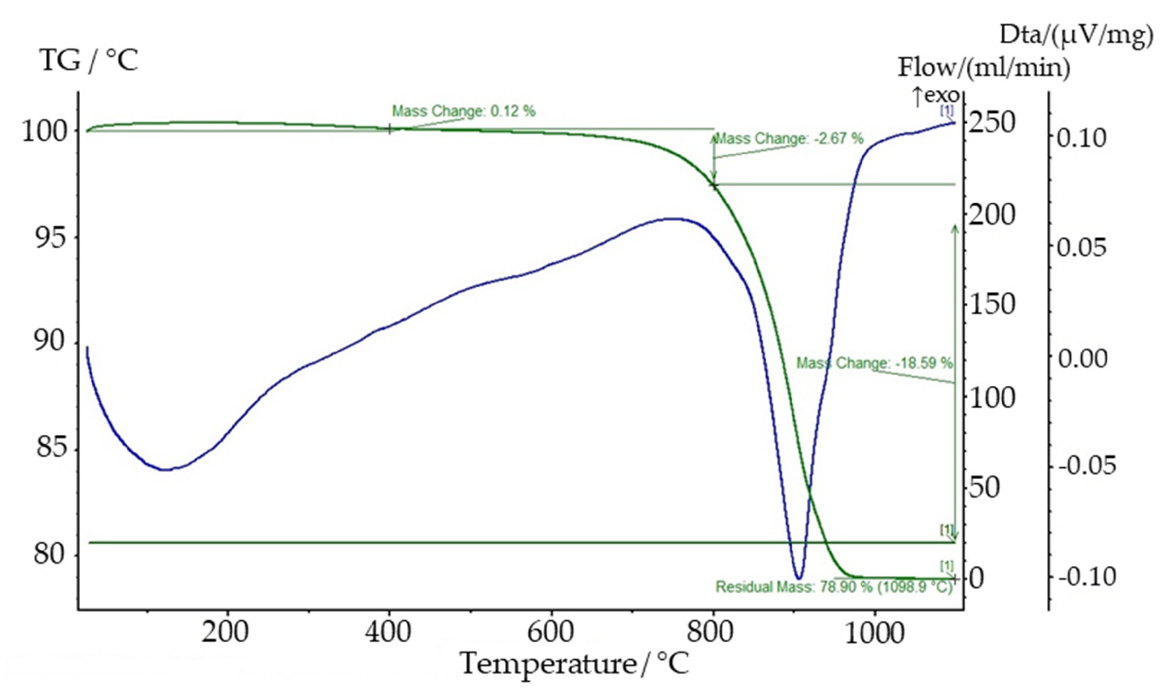
Figure 4. DTA-TGA curves of the wollastonite-calcite sample.